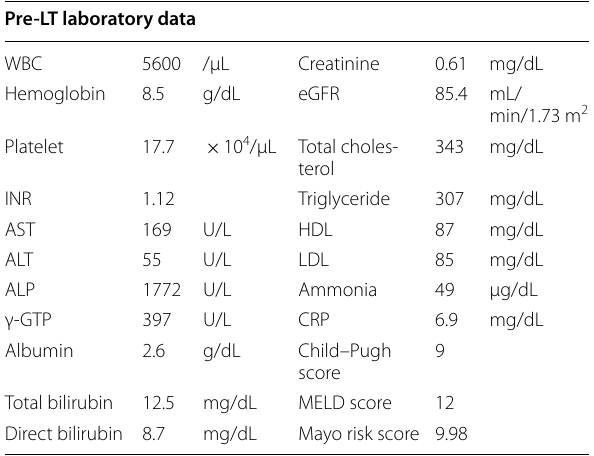
LT liver transplantation, WBC white blood cell, INR international normalized ratio, AST aspartate aminotransferase, ALT alanine aminotransferase, ALP alkaline phosphatase, γ-GTP γ-glutamyl transpeptidase, GFR estimated glomerular filtration rate, HDL high-density lipoprotein, LDL low-density lipoprotein, CRP C-reactive protein, MELD model for end-stage liver disease